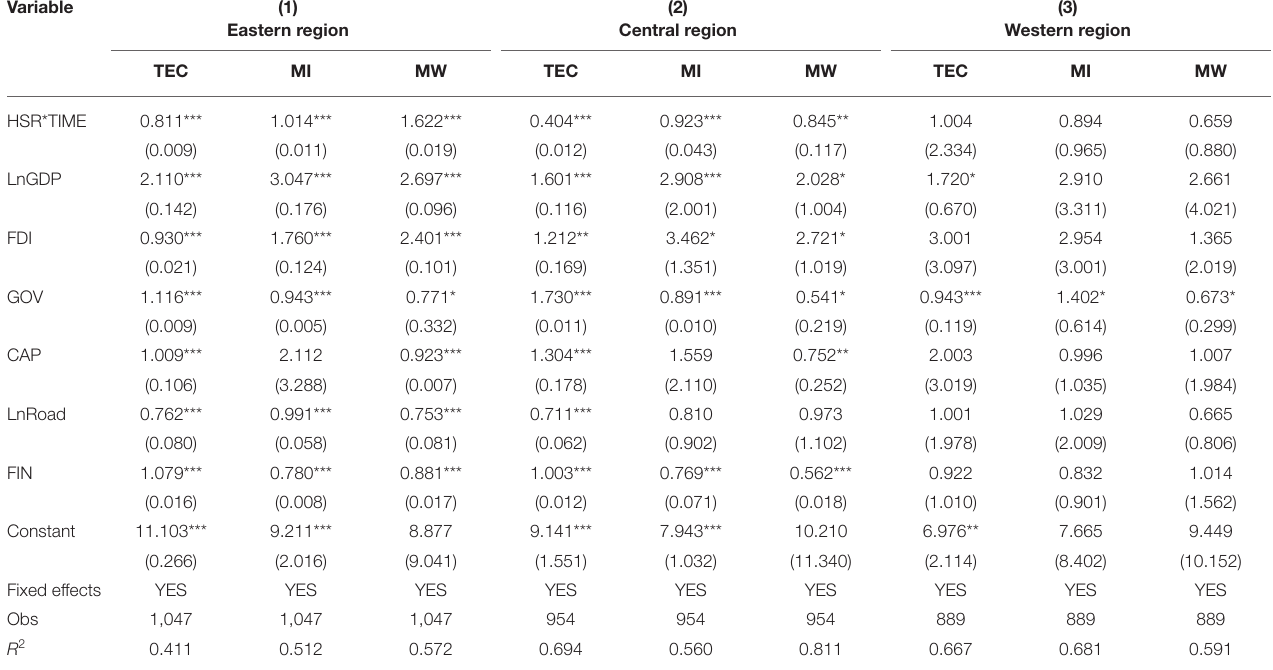
TABLE 2 | Regional test. Variable